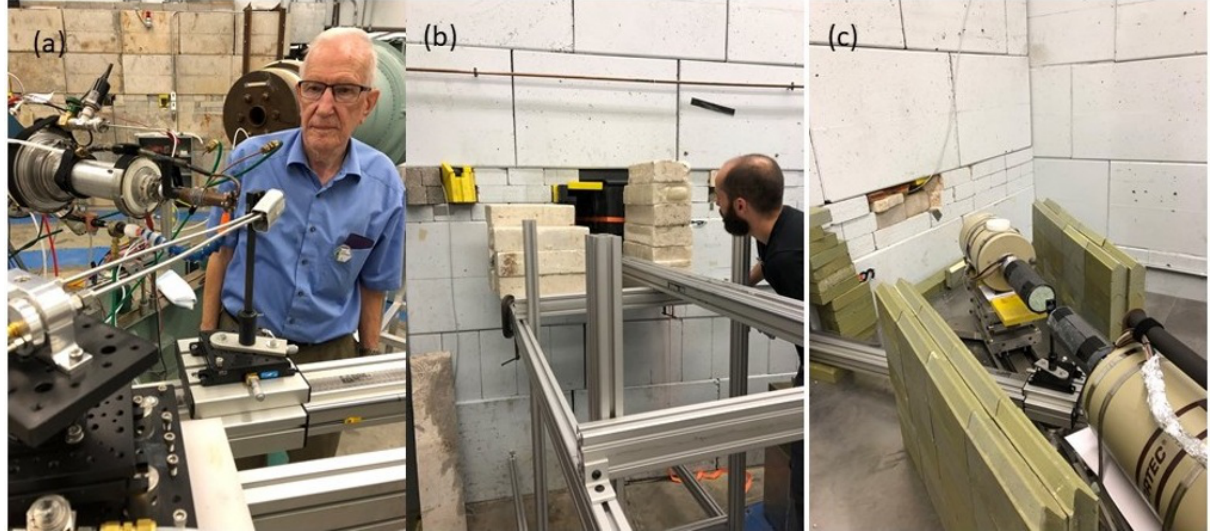
Figure 2. RABITTS system. A picture of the irradiation position is shown in (a). Note the presence of the Cd-shrouded DFC, black sample holder (on plastic rod) used to minimize mass near the sample, and air-cooled neutron target (Cu tube). The sample is transported on a cart riding an Al extruded track through the shielding wall (b) to a separate cave for counting between two HPGe detectors (c). Neutron generation is automatically shut o ff using a rapid switching magnet when the sample is in the counting position to further reduce any backgrounds. The sample is normal to the neutron source and each HPGe